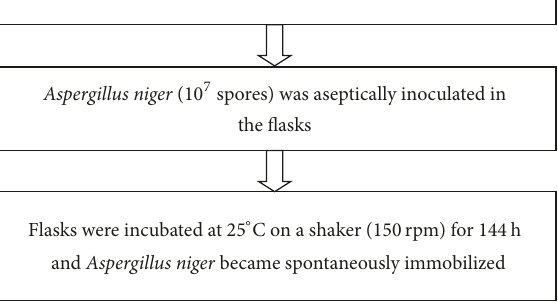
Figure 2: Whole-cell biocatalysts